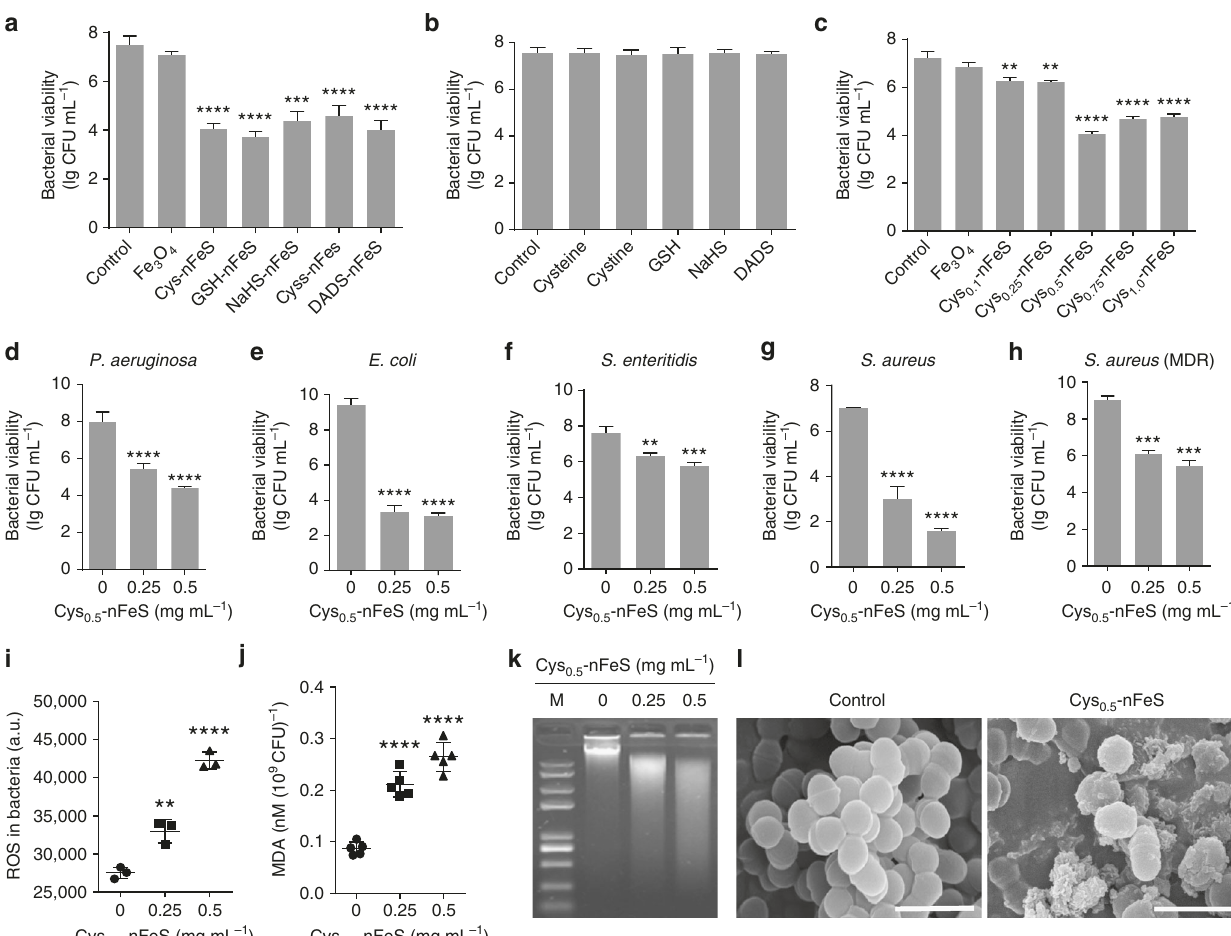
Fig. 2 Antibacterial activity of nFeS. a Antibacterial activity of nFeS converted from different organosulfur sources against S. mutans UA159 (a bio fi lm- forming dental pathogen). Cys-nFeS was derived from cysteine with 0.5 g additive in solvothermal conversion, other nFeS products were synthesized with organosulfur compounds at the amount normalized to the same sulfur content in 0.5 g cysteine. The concentration for each nFeS was adjusted to 0.5 mg mL − 1 in all antibacterial tests. b Antibacterial ( S.mutans UA159) activity of the organosulfur compounds. The concentration for each sulfur compound was normalized to sulfur amount equal to that contained in 0.5 mg mL − 1 of Cys 0.5 -nFeS. c Dependence of antibacterial ( S. mutans UA159) ef fi cacy of Cys-nFeS on the amount of cysteine input to the solvothermal synthesis. The concentration for Fe 3 O 4 nanoparticle or nFeS was at 0.5 mg mL − 1 . d – h Antibacterial activity on P. aeruginosa , E. coli , S. enteritidis , S. aureus , and S. aureus (MDR), respectively. i , j ROS level and lipid peroxidation of bacteria treated by Cys-nFeS. k Genomic DNA degradation of bacteria treated by Cys-nFeS. M: DNA marker. l SEM image of bacteria treated by Cys-nFeS. Scale bars: 1 µ m. Data are shown as the mean ± s.d. Statistical signi fi cance was assessed by unpaired Student ’ s two-sided t -test compared to the control group. ** p < 0.01, *** p < 0.001 and **** p < 0.0001. Mean values and error bars were de fi ned as mean and s.d., respectively. All experiments were performed in triplicate, and representative images are